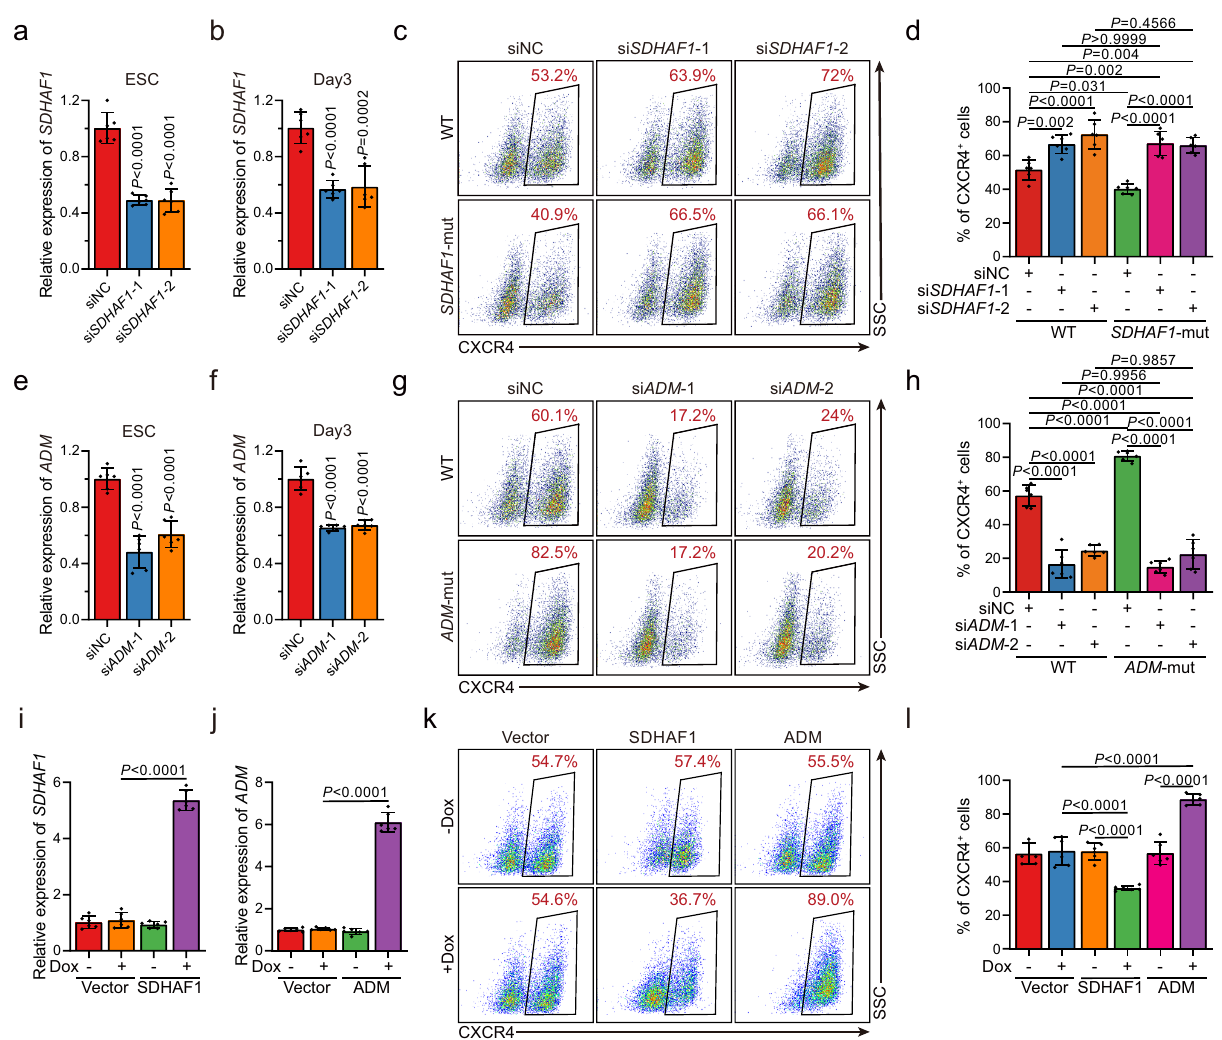
Fig. 6 The mRNAs of SDHAF1 and ADM mediate the effects of their targeting sgRNAs on DE speci fi cation. a , b siRNA knockdown ef fi ciency of SDHAF1 in hESCs ( a ) and at day 3 of DE differentiation ( b ), respectively ( n = 6 biologically independent samples), measured by RT-qPCR. si siRNA, NC non- targeting control. P -values were calculated vs. siNC (one-way ANOVA with Tukey ’ s post hoc test). c , d Representative ( c ) and quantitative ( d ) fl ow cytometry analyses of CXCR4 expression in cultures derived from WT or SDHAF1- mut hESCs that with NC or SDHAF1 -targeting siRNAs at day 3 of DE differentiation ( n = 6 biologically independent samples). ns non-signi fi cant (one-way ANOVA with Tukey ’ s post hoc test). e , f siRNA knockdown ef fi ciency of ADM in hESCs ( e ) and at day 3 of DE differentiation ( f ) respectively ( n = 6 biologically independent samples), measured by RT-qPCR. si siRNA, NC non- targeting control. P -values were calculated vs. siNC (one-way ANOVA with Tukey ’ s post hoc test). g , h Representative ( g ) and quantitative ( h ) fl ow cytometry analyses of CXCR4 expression in cultures derived from WT or ADM -mut hESCs that with NC or ADM -targeting siRNAs at day 3 of DE differentiation ( n = 6 biologically independent samples). ns non-signi fi cant (one-way ANOVA with Tukey ’ s post hoc test). i , j mRNA levels of SDHAF1 ( i ) and ADM ( j ) in overexpressed hESCs ( n = 6 biologically independent samples), measured by RT-qPCR. Dox, doxycycline (one-way ANOVA with Tukey ’ s post hoc test). k , l Representative ( k ) and quantitative ( l ) fl ow cytometry analyses of CXCR4 expression in cultures derived from WT and overexpressed hESCs at day 3 of DE differentiation ( n = 6 biologically independent samples). Dox doxycycline (one-way ANOVA with Tukey ’ s post hoc test). Data of all relevant panels are presented as means ± SD. Source data are provided as a Source Data fi